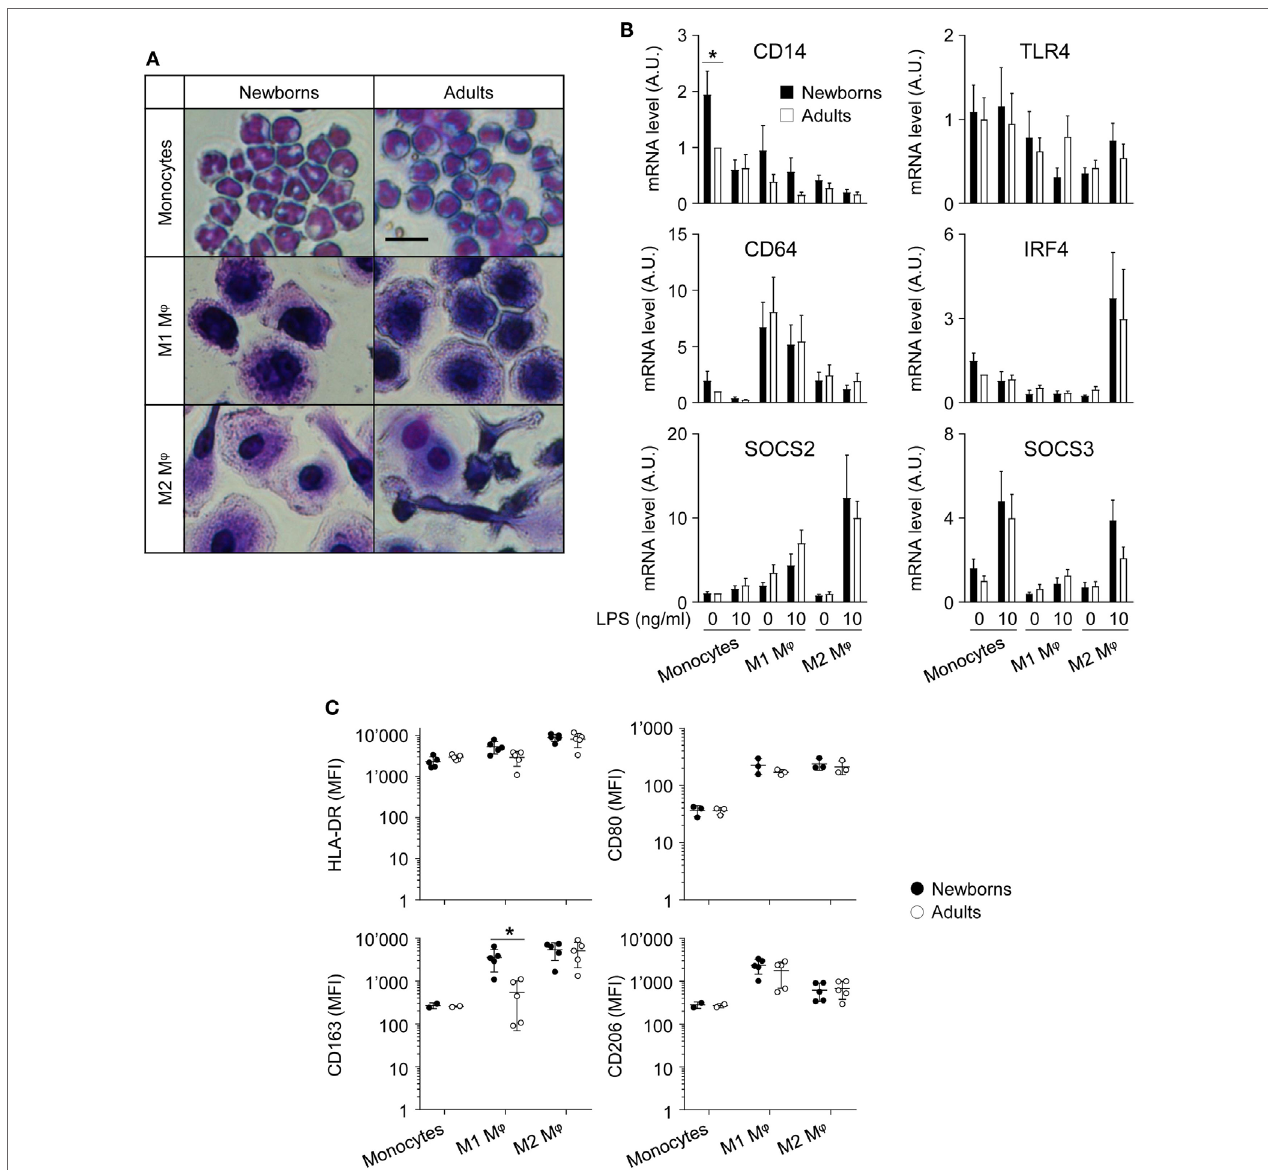
FigUre 1 | Adult and newborn monocytes differentiate into M1 or M2 macrophages following exposure to GM-CSF or M-CSF. Freshly isolated monocytes were cultured for 7 days with GM-CSF and M-CSF (50 ng/ml) to induce M1 and M2 macrophages. (a) Hematoxylin and eosin staining of monocytes and M1 and M2 macrophages. Scale bar = 30 µm. Data are representative of results obtained from five newborns and five adults. (B) CD14, TLR4, CD64, SOCS2, and IRF4 mRNA expression levels in newborn (black bars) and adult (white bars) monocytes and M1 and M2 macrophages were measured by RT-PCR. Data are means ± SEM from eight newborns and eight adults. (c) HLA-DR, CD80, CD163, and CD206 mean fluorescence intensity in newborn (black circles) and adult (white circles) monocytes and M1 and M2 macrophages was analyzed by flow cytometry in three to five healthy newborns and adults. Each dot represents one subject. CD163 and CD206 were not detected in monocytes from 2/5 newborns and 2/5 adults. Means ± SEM are presented. * P <